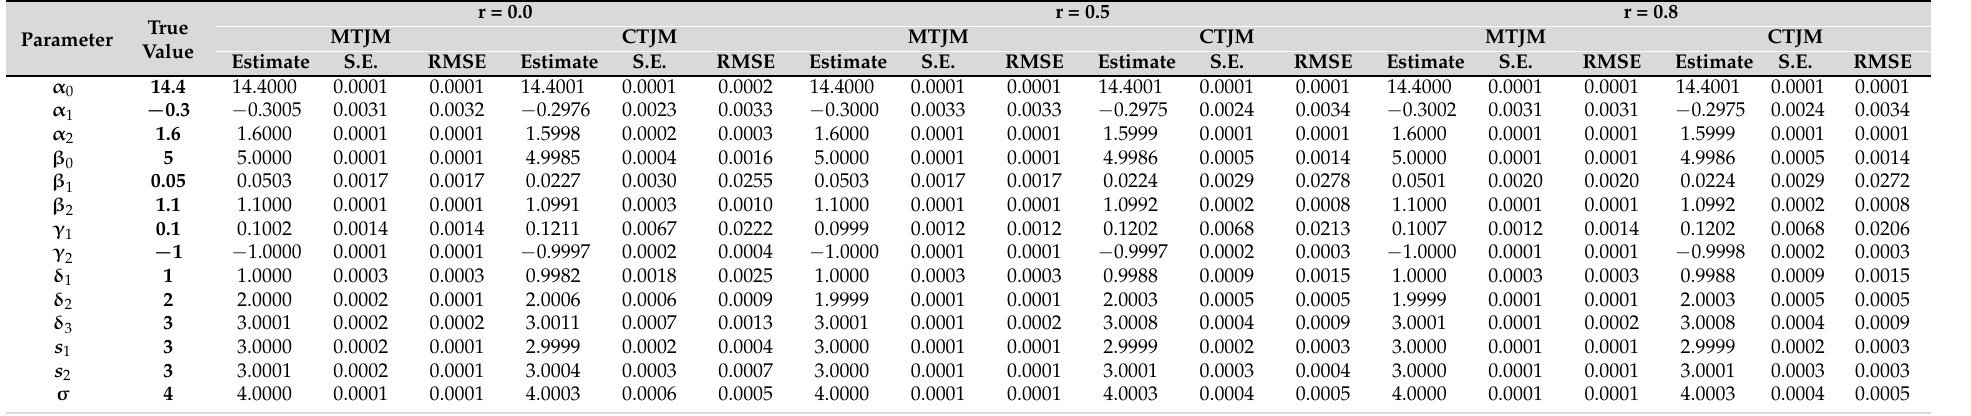
Table 2. Simulation results for MTJM and CTJM under n =